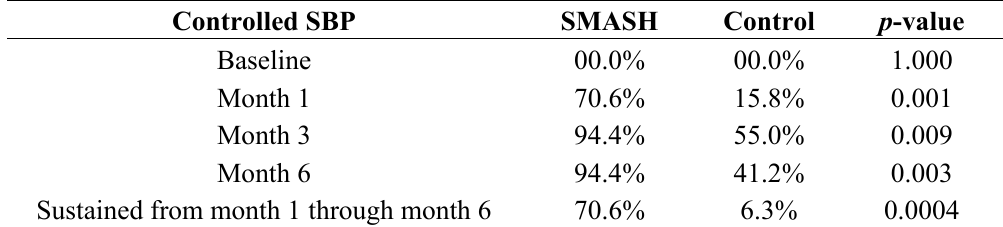
Table 2. Proportion of participants by Group with SBP controlled.